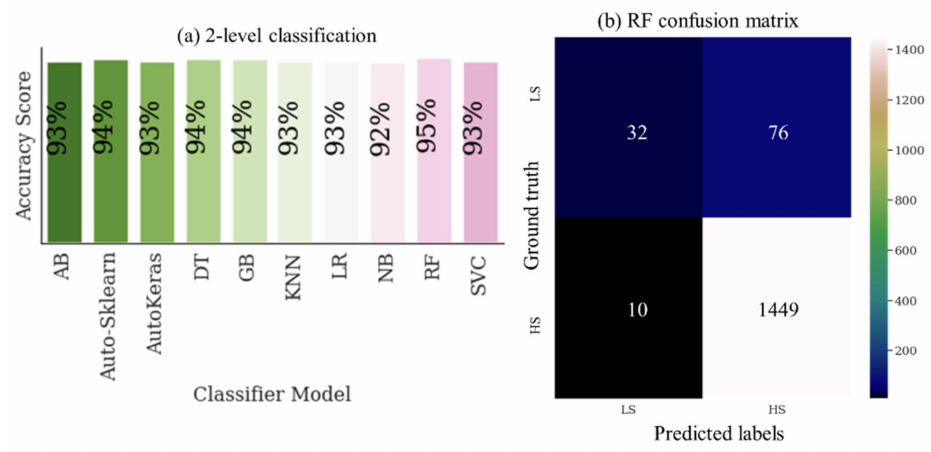
Figure 5. ( a ) 2-level accuracy performance. ( b ) Confusion matrix for RF.